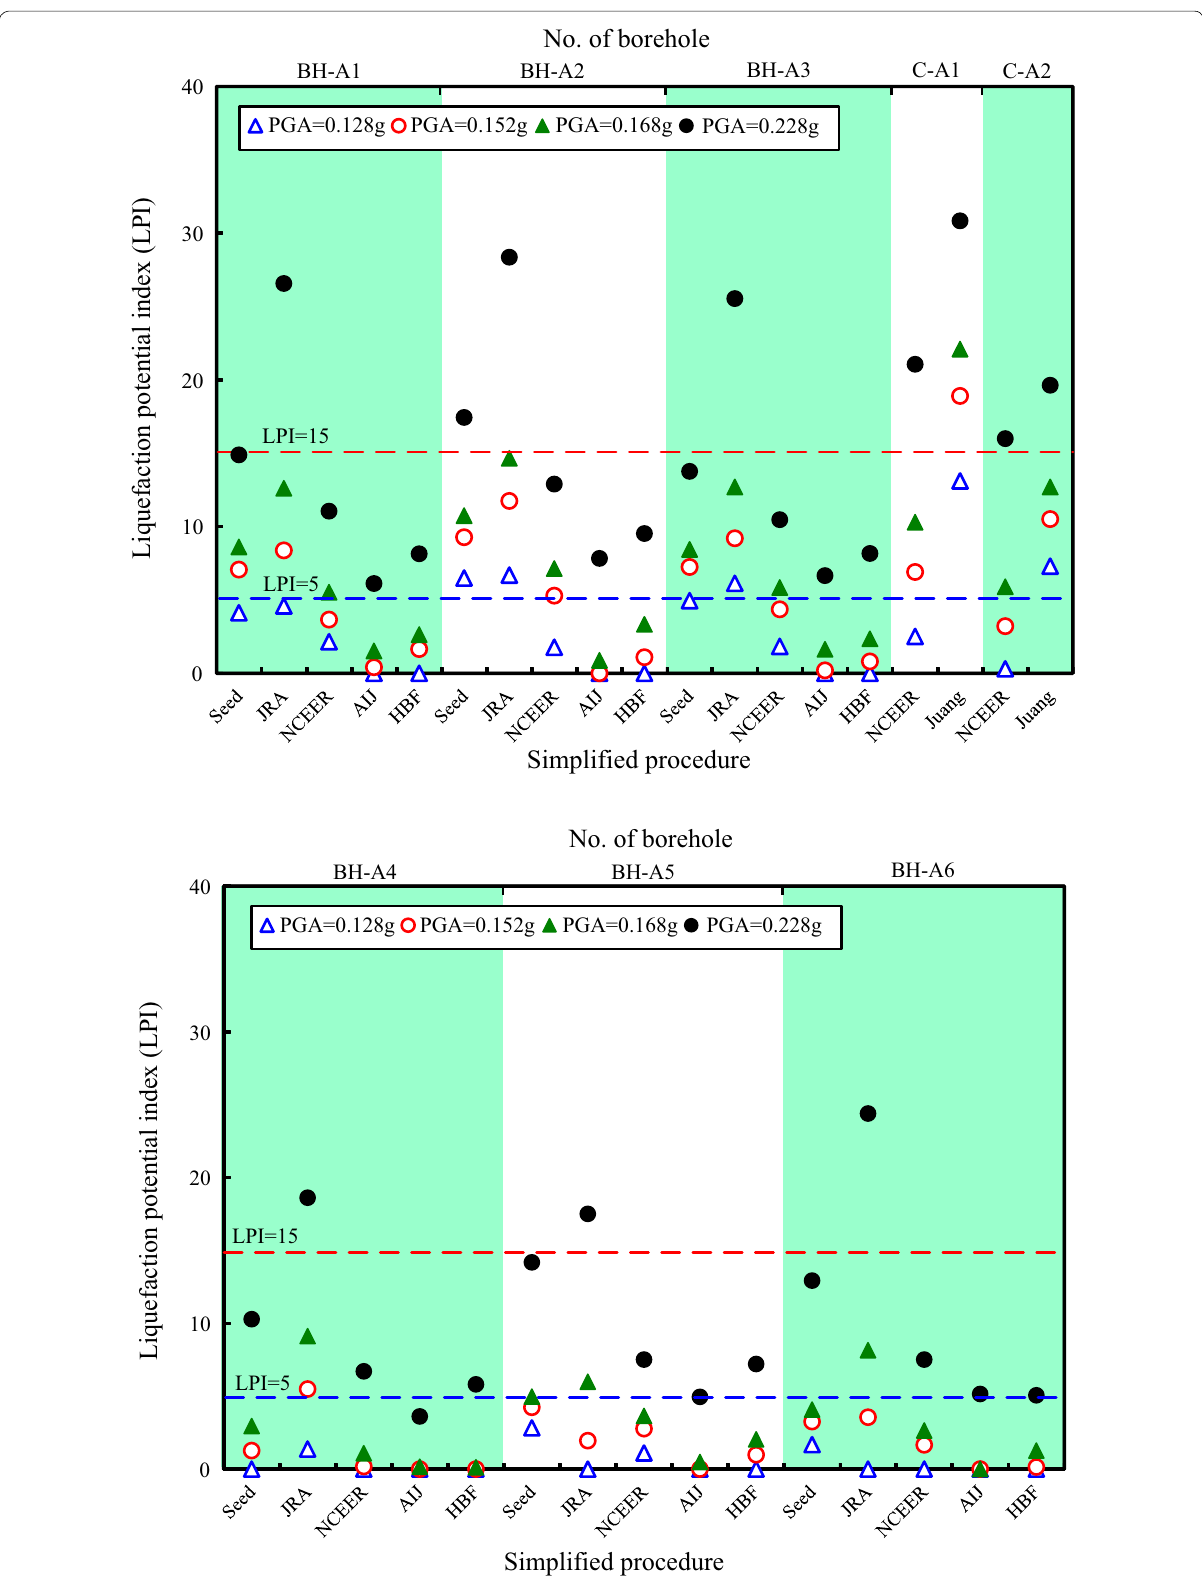
Fig. 9 Evaluated LPI for the Annan District by different simplified methods and